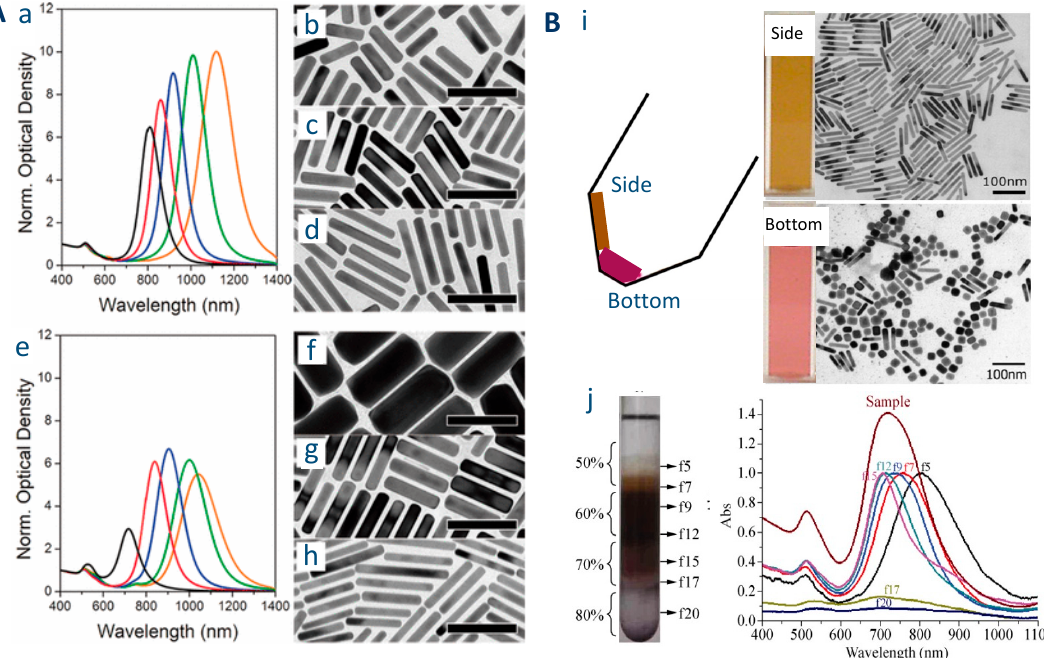
Figure 3. ( A ) Increasing AuNRs monodispersity: ( a – d ) Comparison between the use of small AuNRs seeds in the two step growth method and ( e – h ) standard Au nanocrystal seeds of 1–2 nm in conventional method in the growth of AuNRs at increasing [HCl] / [HAuCl 4 ] ratios and their respective TEM images and normalized absorption spectra. Adapted from [53]. Scale bars: 100 nm. Purification methods: ( B ) ( i ) Separation of AuNRs from Au nanospheres after conventional centrifugation; TEM pictures of the particles deposited (top) on the side wall and (bottom) at the bottom of the centrifugation tube. Adapted from [54] and ( j ) picture of AuNR suspension after gradient centrifugation in aqueous cetyltrimethylammonium bromide (CTAB)-ethylene glycol solution and UV-vis spectra of the colloidal suspensions recovered at di ff erent positions in the centrifugation tube. Adapted from [55].